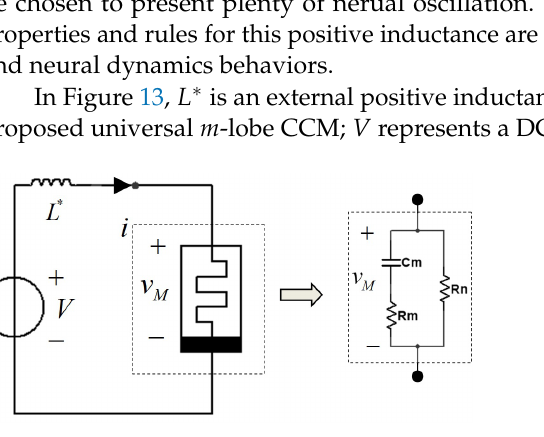
Figure 13. Oscillator circuit of universal m -lobe CCM oscillator.